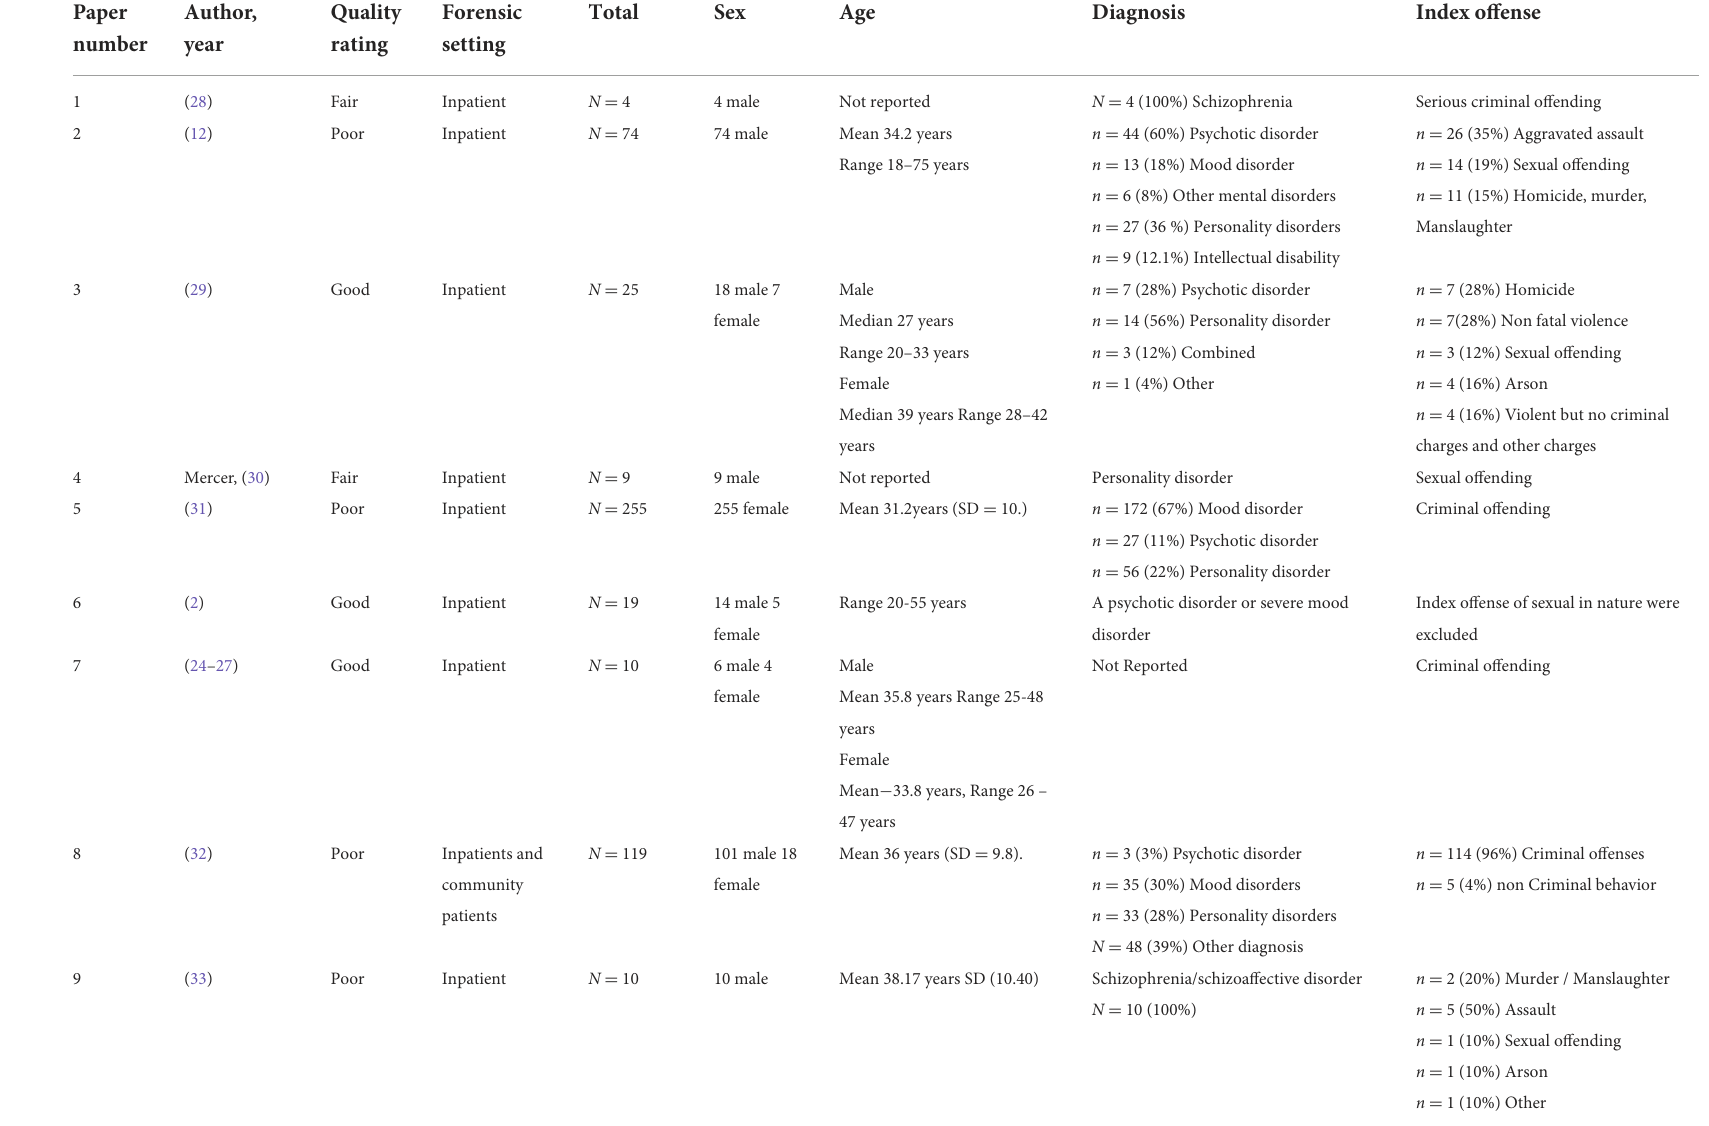
TABLE 3 Forensic mental health patient population